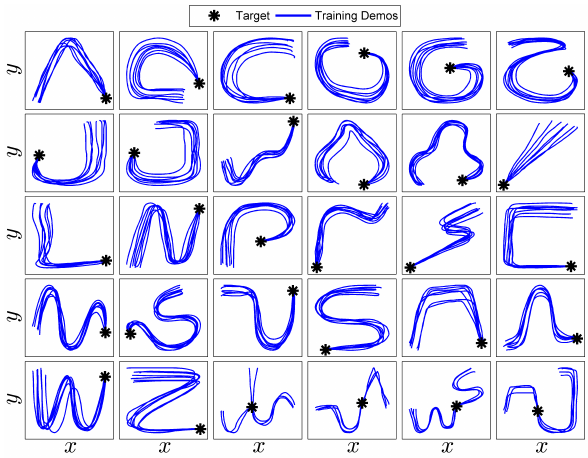
Figure 2: The library of LASA handwriting motions [26]. This library is composed of N = 30 two-dimensional point-to-point